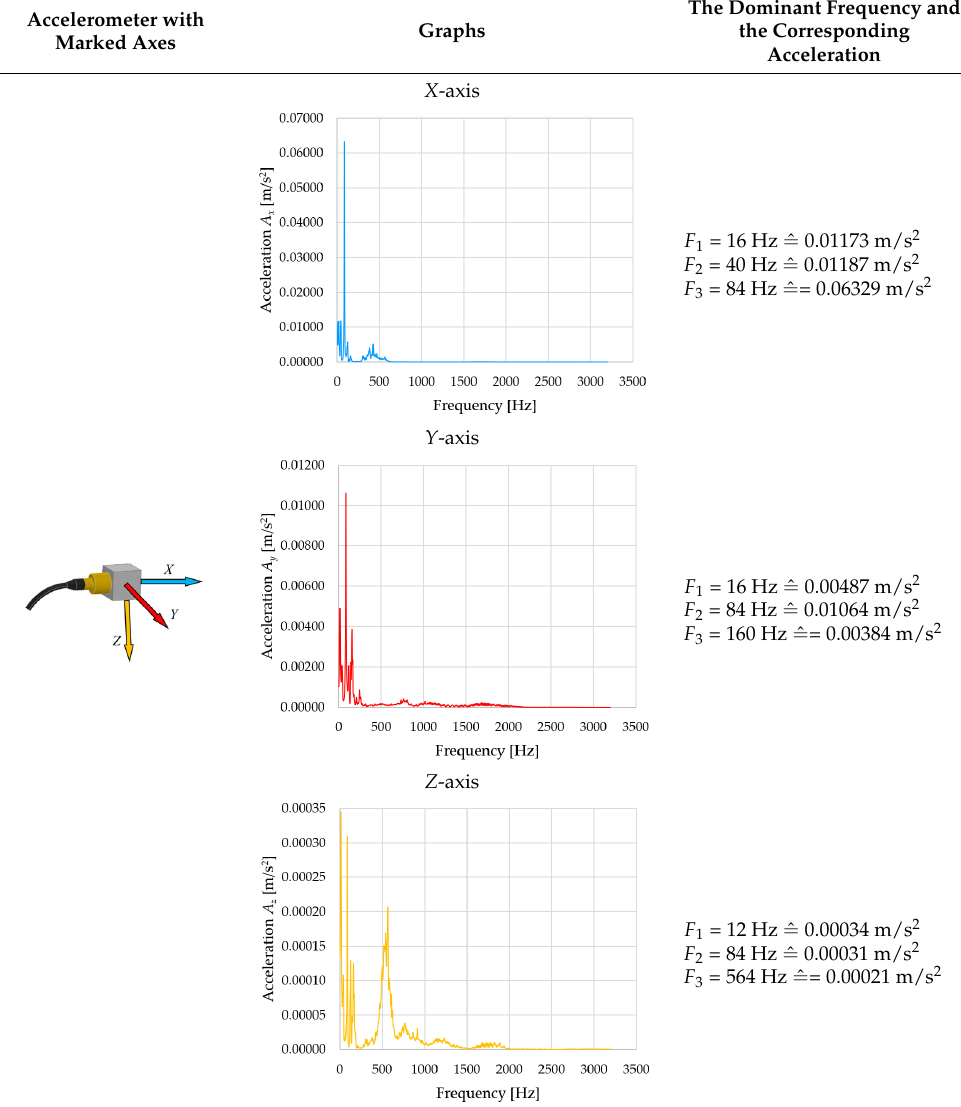
Table 3. The course of acceleration depending on the frequency for velocity 20 % (26.2°/s). Accelerometer with Marked Axes